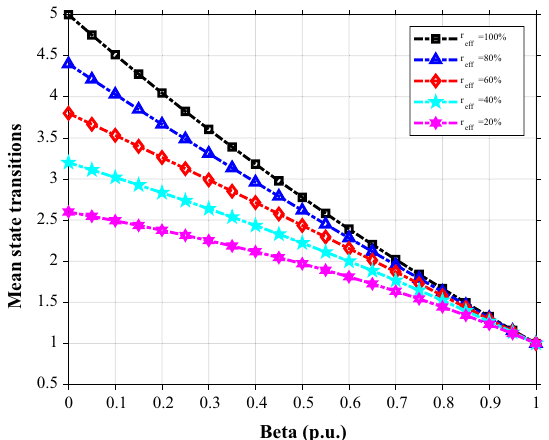
Fig. 17 Sensitivity and elasticity of system to CCF—High diagnostic